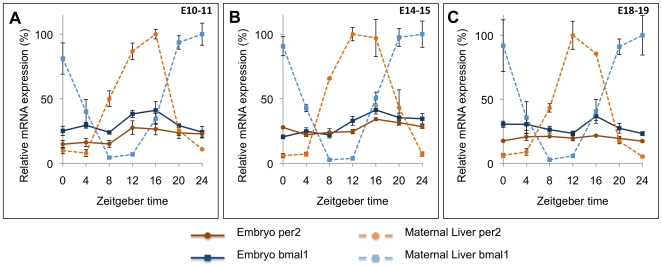
Twenty-four-hour expression profiles of Per2 and Bmal1 mRNA in whole embryos and maternal liver during embryogenesis.Whole embryos were collected every 4 hours for 24 hours on E10-E11 (A), E14-E15 (B) and E18-E19 (C) and mRNA was measured using quantitative real-time RT-PCR. The 0 and 24 hour time points were repeated, independent measures of the same time of day. Maternal livers demonstrated robust variation in both Per2 and Bmal1 at all ages (P<0.0001), consistent with the rhythms expected for these genes. The mRNA of whole embryos failed to show a clear rhythm in either Per2 or Bmal1 at E10-E11 and E18-E19. Low but statistically significant fluctuations were observed for Per2 and Bmal1 at E14-E15 (p<0.01). RNA levels were normalized to the control gene, gapdh. Symbols represent the mean ± standard error of the mean (SEM) of three biological replicates. The maximum maternal liver RNA for each stage of gestation was set to 100 and the rest of maternal and embryonic samples are presented relative to that maximum.